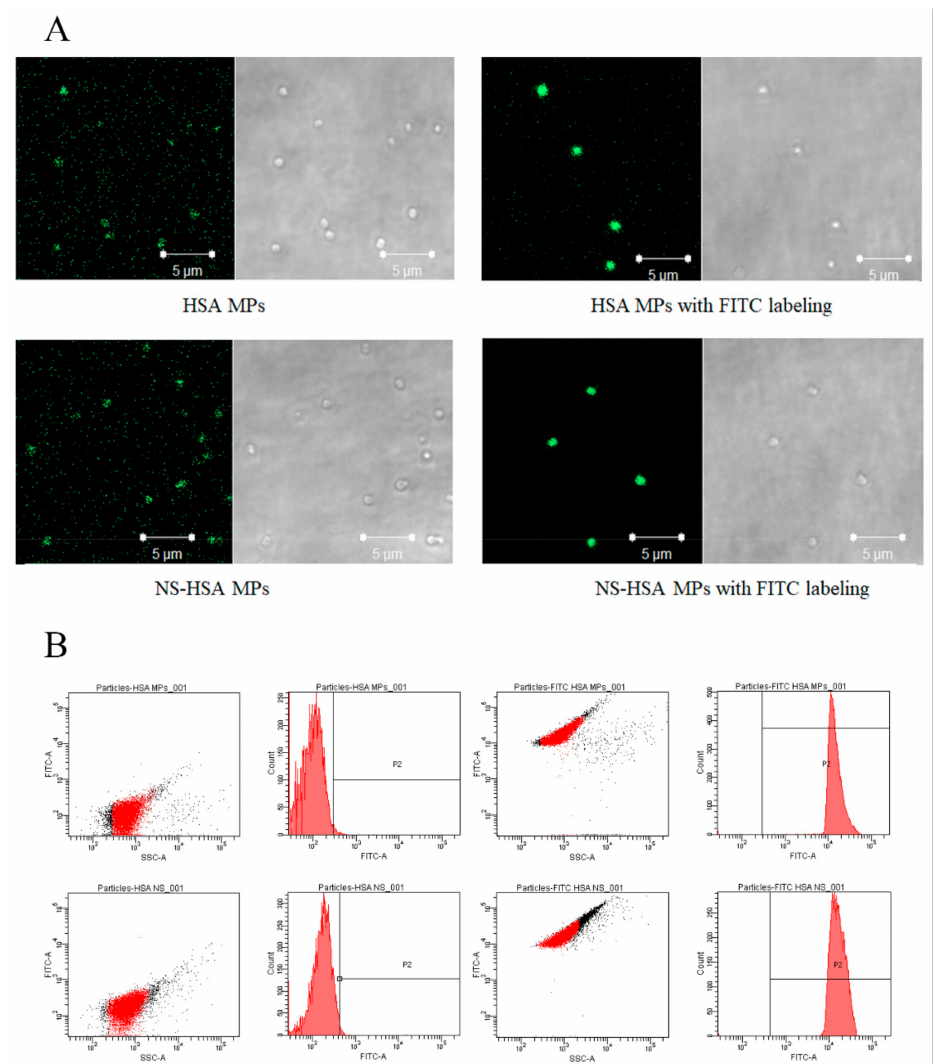
Figure 6. Human serum albumin micro particles, HSA-MPs, and non-sericin loaded human serum albumin micro particles, NS-HSA-MPs, after FITC labeling and nonlabeling indicated that the fluorescent particles were higher than the nonlabeled particles after observed by CLSM ( A ) and after investigated by FACS ( B